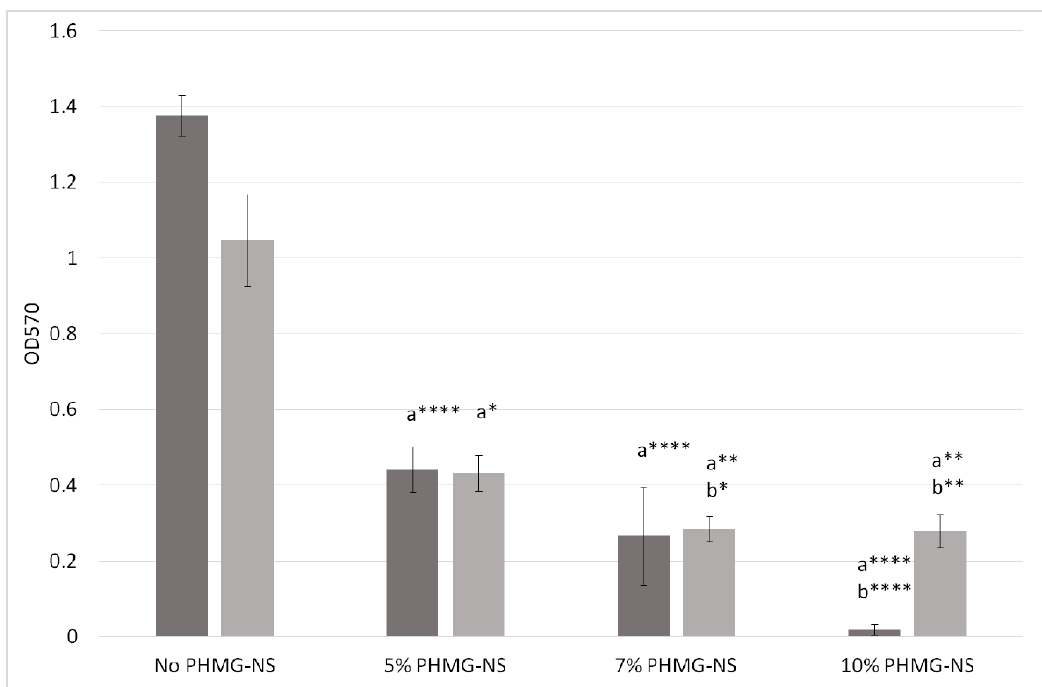
Figure 4. The level of metabolic activity of E. coli K12 (dark grey) and S. aureus ATCC 25923 (light grey) biofilms formed onto PA-11 films containing 5%, 7% and 10% of PHMG-NS following 72 h of incubation determined by MTT staining and measured as the optical density at 570 nm (OD570). a: statistical significance compared to control (No PHMG-NS); b: statistical significance compared to 5% PHMG-NS. * p < 0.05, ** p < 0.01, **** p < 0.001.